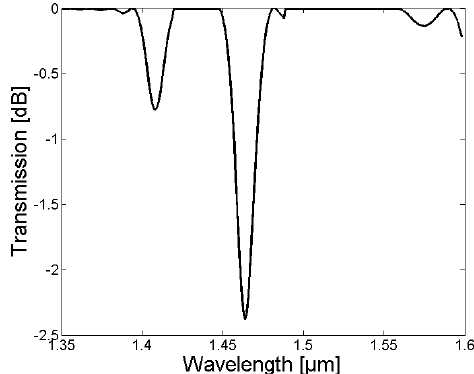
Figure 5. The resulting simulated LPG spectrum in the tapered SM1500 single ‐ mode fiber with a starting cladding diameter of 125 μ m, an extension of 28 mm, a grating period of 370 μ m, a grating length of 8 mm, and a refractive index change within the grating of δ n = 1 × 10 − 3 .